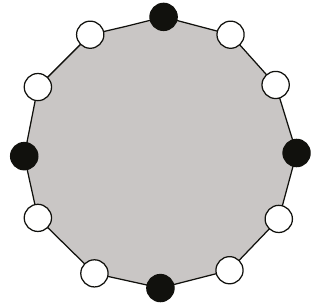
Figure 11: Four-agent/12-vertex